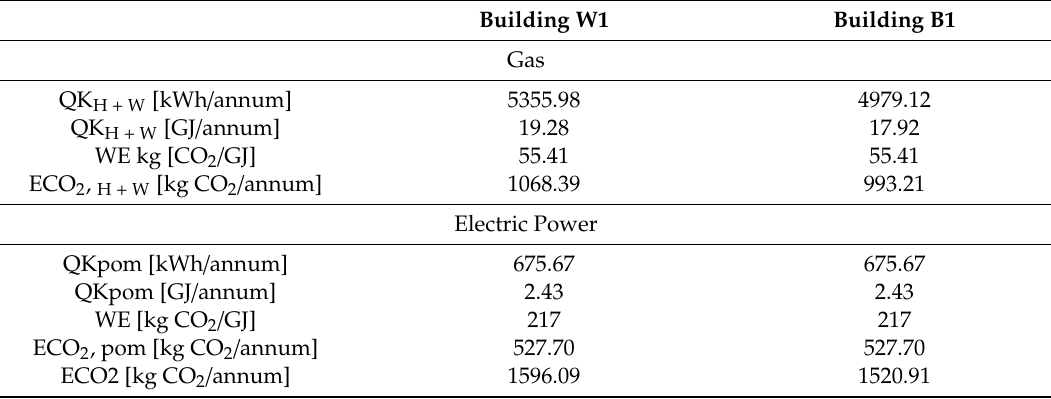
Table 9. CO 2 emission calculations.